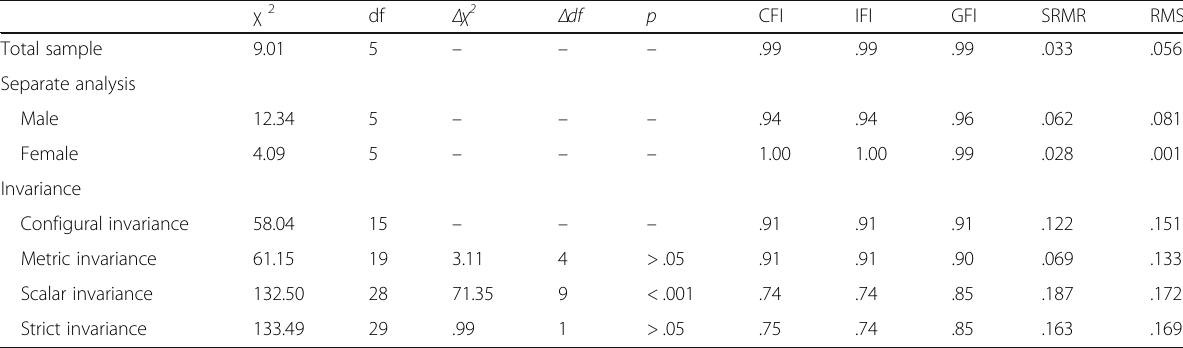
Table 2 Fit indexes of